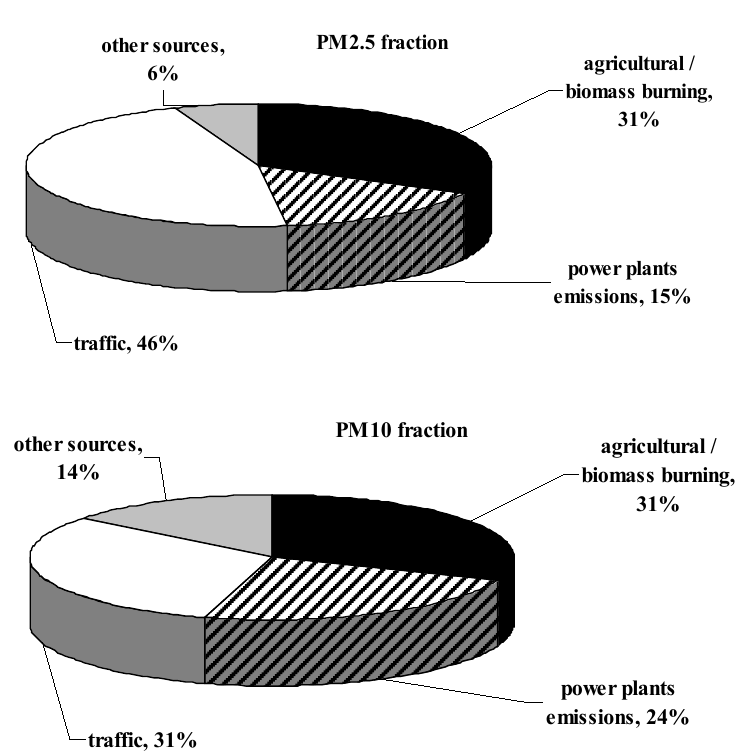
Figure 4. % percentages of sources contribution to PM2.5 and PM10